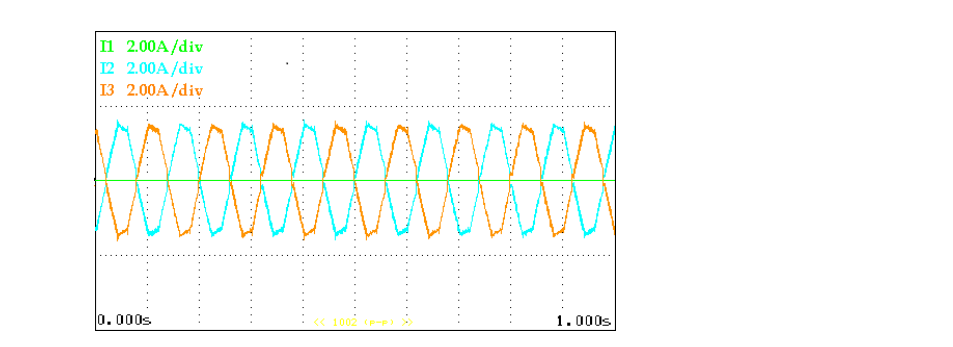
Figure 13. Currents in the BLDC motor operating under phase fault condition without current re- duction strategy.